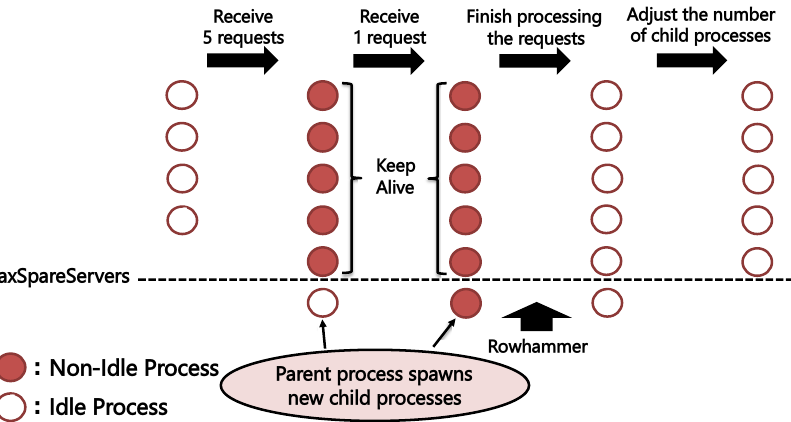
Figure 5. Process by which the server-parent process creates new child processes. When the number of non-idle processes running is equal to the MaxSpareServers value, the server-parent process creates a new child process for an additional